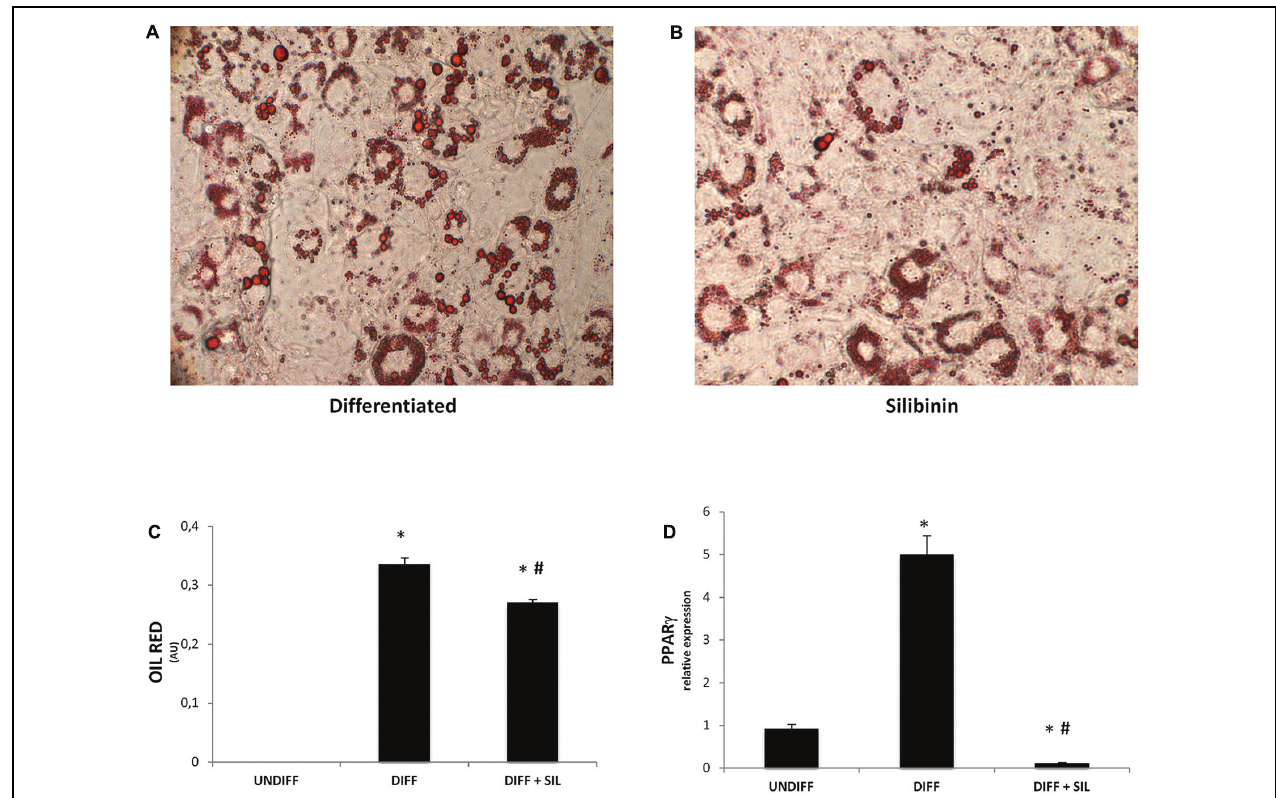
FIGURE 1 | (A–B) Lipid droplets accumulation measured by Oil red staining in differentiated cells in presence (B) or absence of silibinin (A) . (C) Oil Red staining measured by spectrophotometer ( λ = 490 nm) in undifferentiated cells and after 14 Days of adipogenic differentiation in presence or absence of silibinin. (D) PPAR γ gene expression was evaluated by Real Time PCR. All values are expressed as mean ± SEM of four experiments ( n = 4) in duplicate. ∗ P < 0.05 vs. undifferentiated; # P < 0.05 vs.